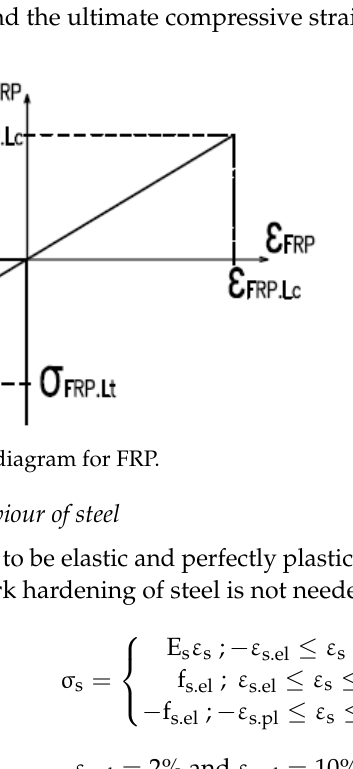
Figure 4. Stress–strain diagram for FRP.